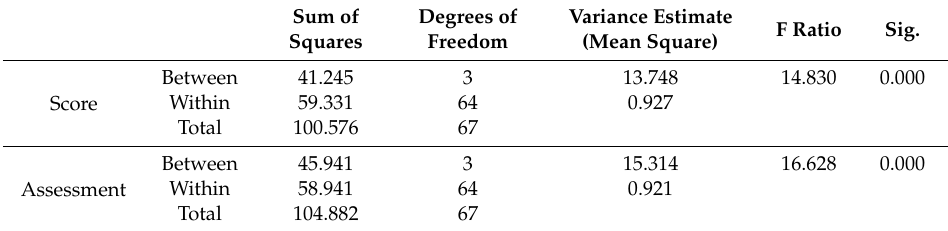
Table 8. Results of the ANOVA analysis for testing the significance of type of e-learning activity.